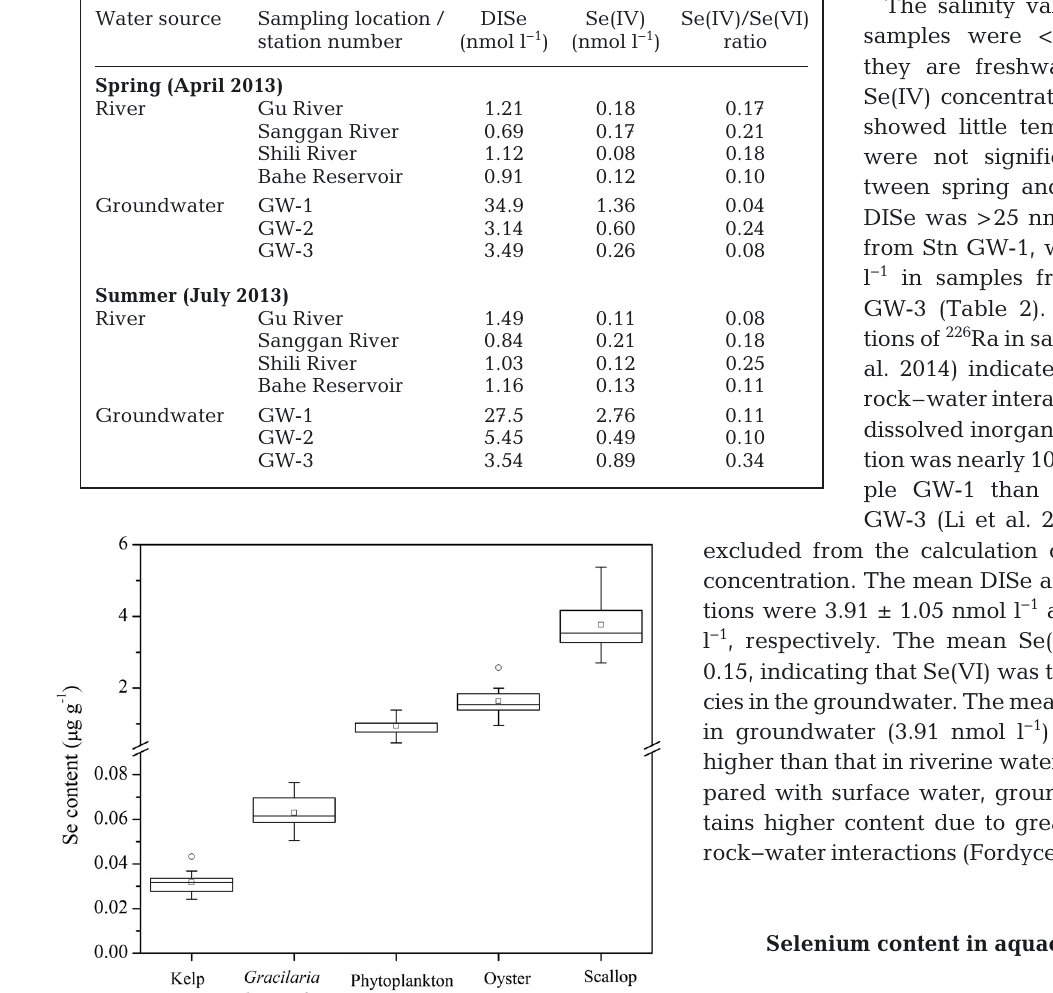
Table 2. Concentrations of dissolved inorganic selenium (DISe) and Se(IV) and Se(IV)/Se(VI) ratio in major rivers that enter into Sanggou Bay and in ground - water (GW) along the coastline of Sanggou Bay, measured in April and July 2013